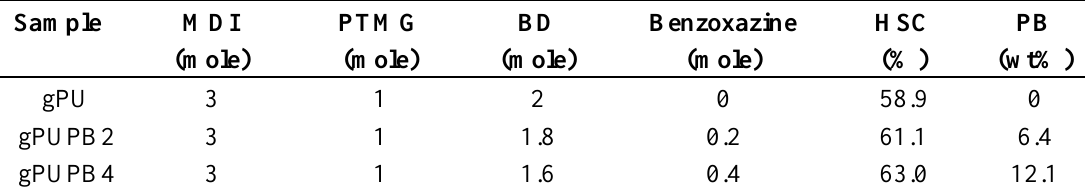
Table 1. Molar ratio of ingredients, hard segment content (HSC), and weight percent of benzoxazine in SMPU with amorphous